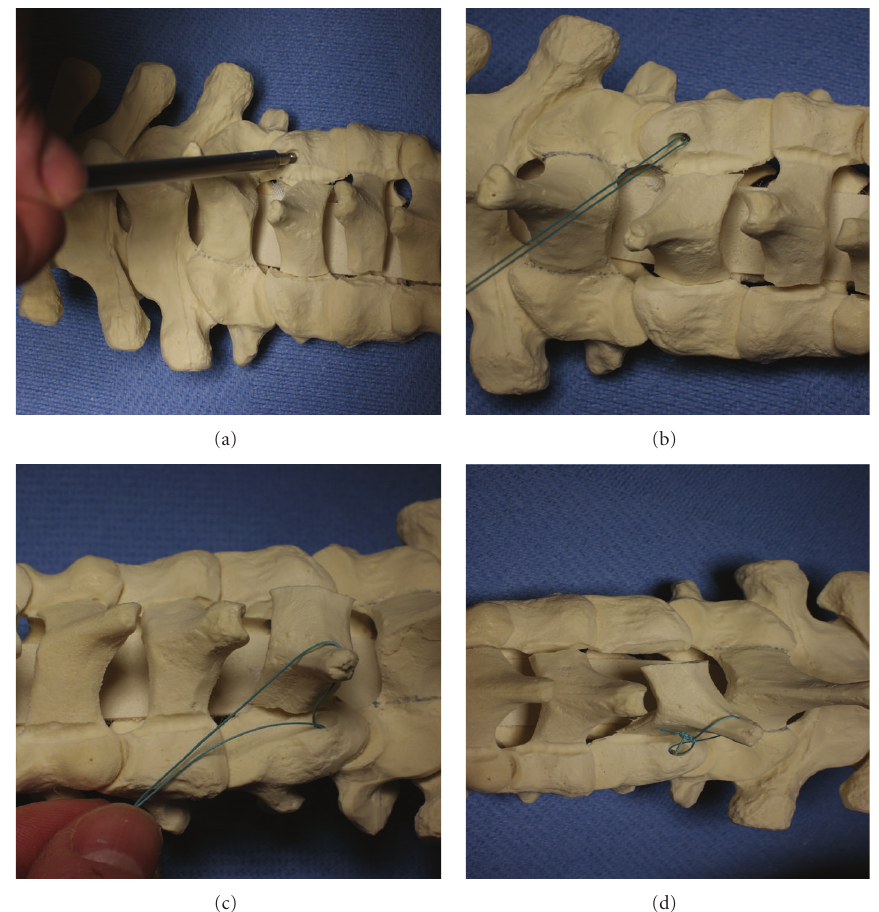
Figure 5: Once the door is opened, the laminae can be held in the open position with suture anchors. Suture anchors are placed into the lateral masses of the hinge as shown in (a) and (b). Next, the suture anchor is brought through a drill hole in the spinous process (c). The suture is tied to prevent closure of the laminoplasty (d).